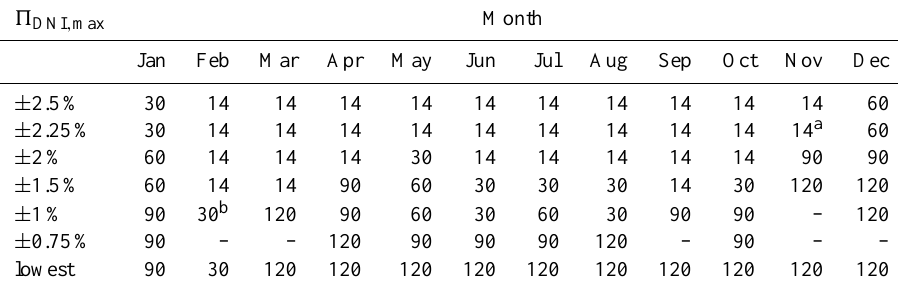
Table 6. DLR2008: Minimum required calibration duration in days for given maximum of (cid:53) DNI and starting time. (cid:53) DNI , max Month Jan Feb Mar Apr May